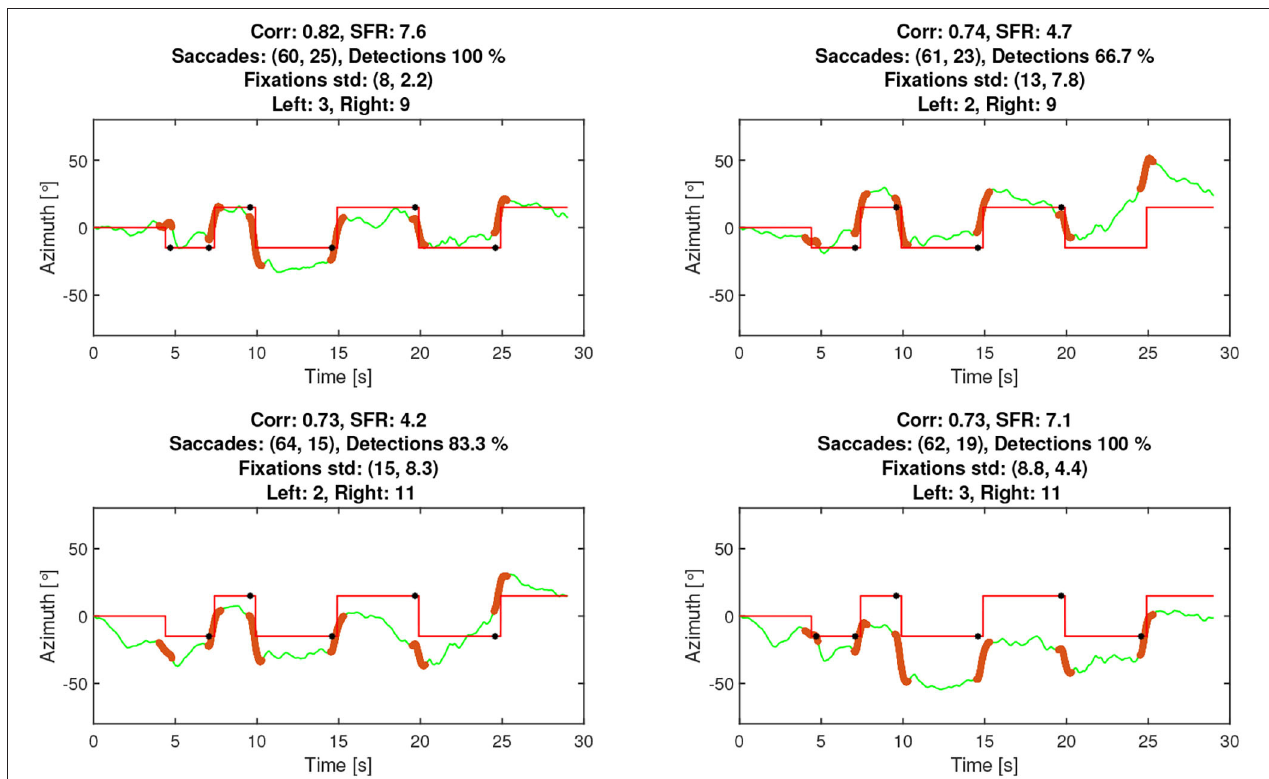
FIGURE 7 | Example of attended speaker estimation data from a trial with participant TP1743. The solid red line represents gaze in degrees from the eye-tracker, the dashed blue line is the in-ear EOG signal, which is scaled for illustration purposes, the yellow and green asterisks are the eye-tracker-attended speakers while the black and magenta small dots are the in-ear EOG-attended speakers. Values below and above 0 deg. refer to left- and right-hand speakers,